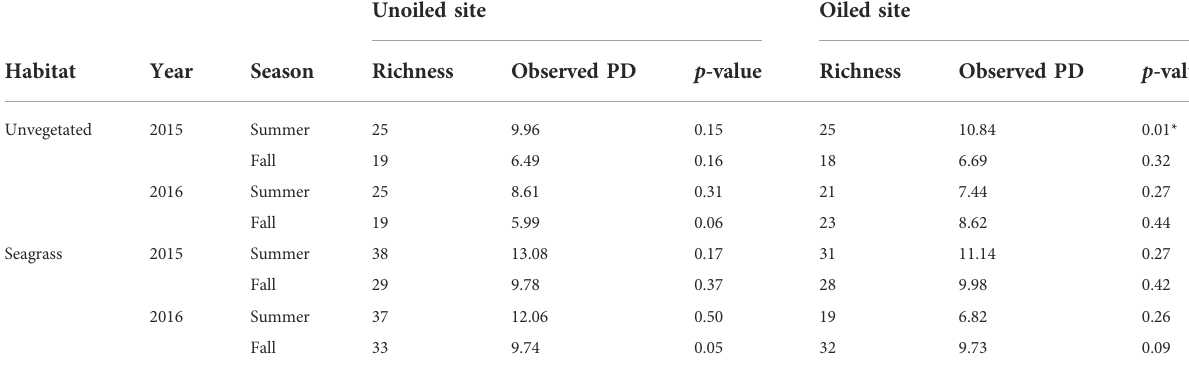
TABLE 1 Observed PD values and family richness by site, habitat, season, and sampling year for each of the 16 community trees.